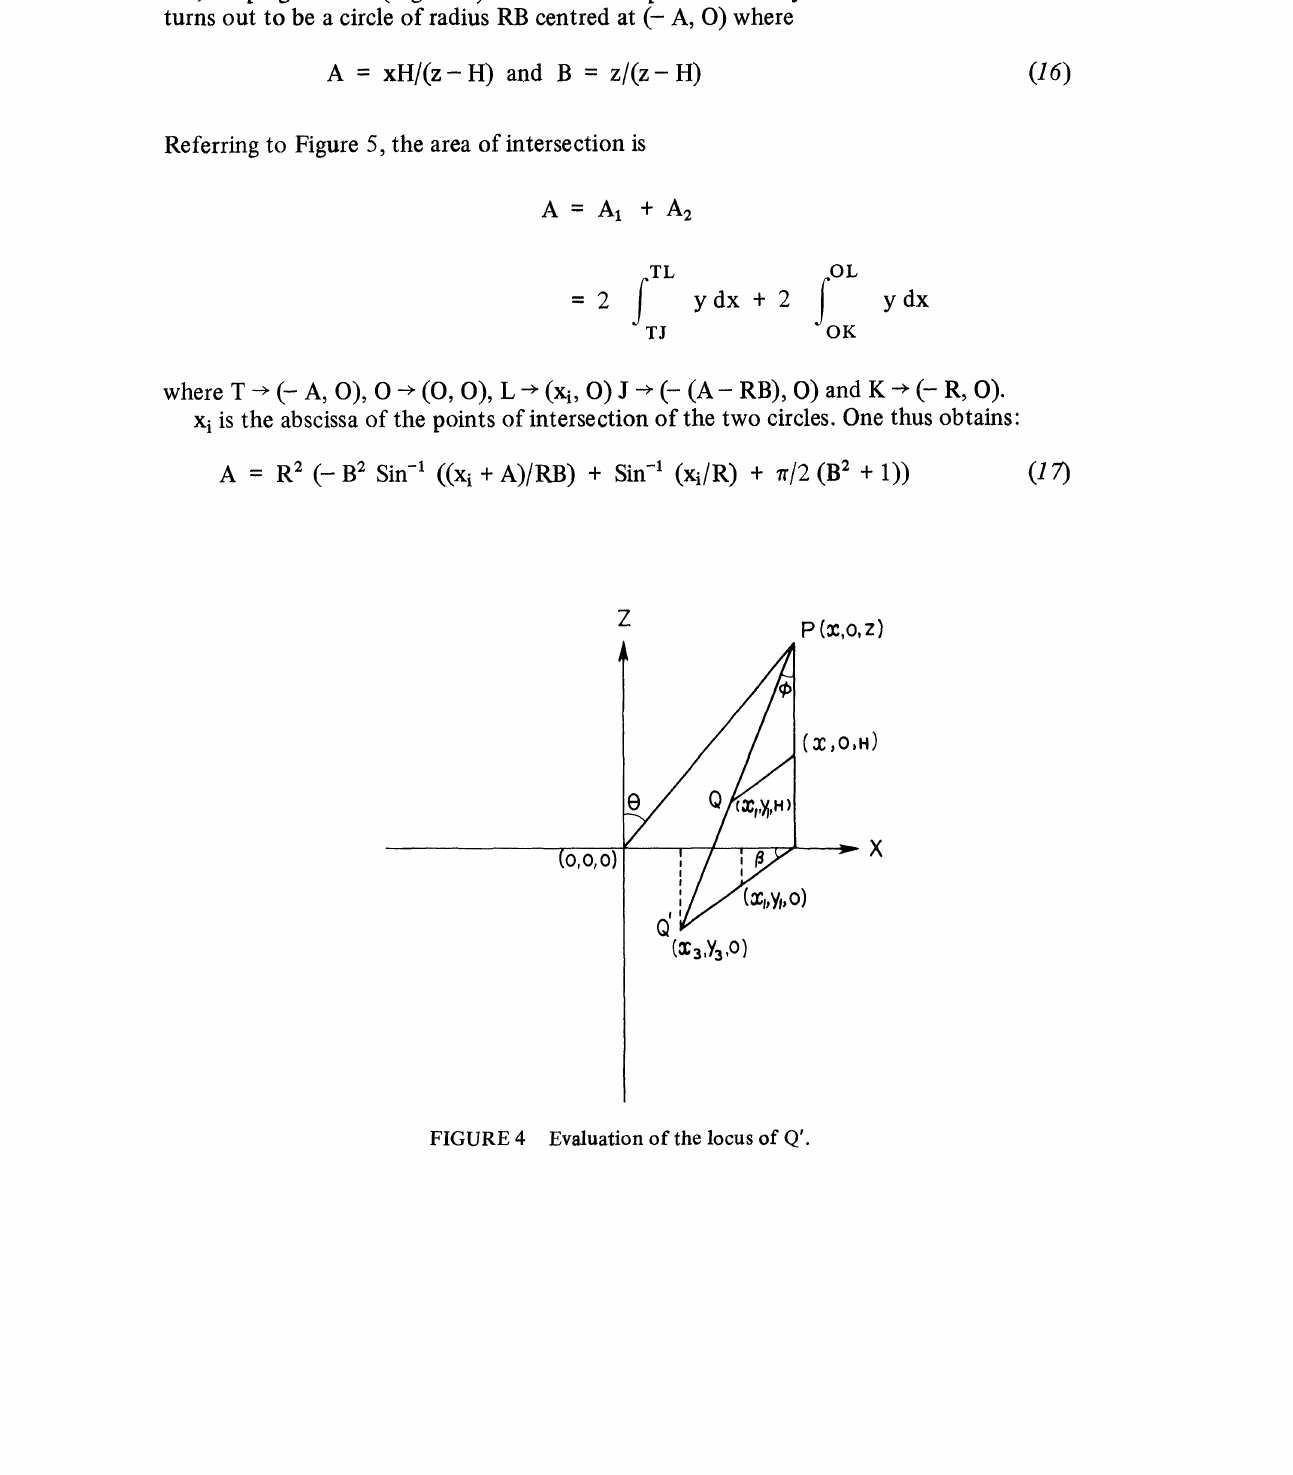
FIGURE 4 Evaluation of the locus of